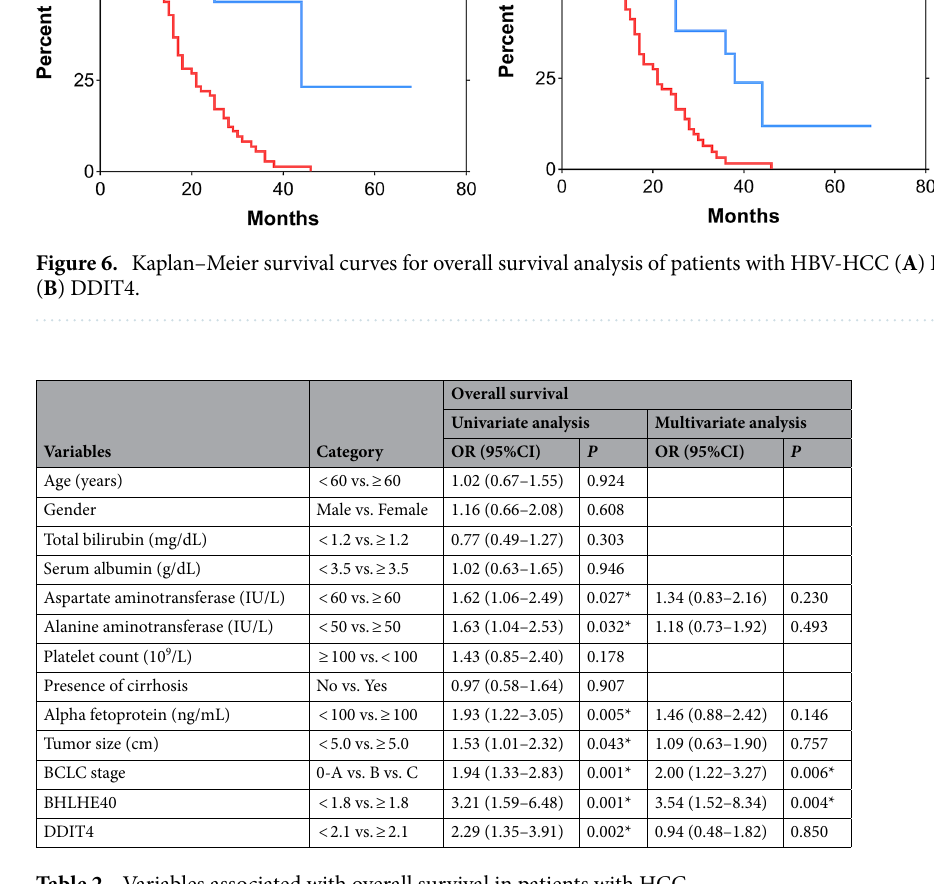
Table 2. Variables associated with overall survival in patients with